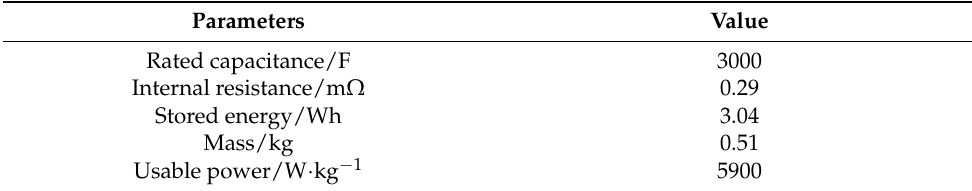
Table 3. BACP3000 SC